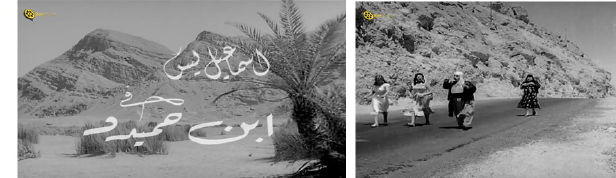
Figure 3 . Sukhna as depicted in the 1957 film Ibn Hamedo .